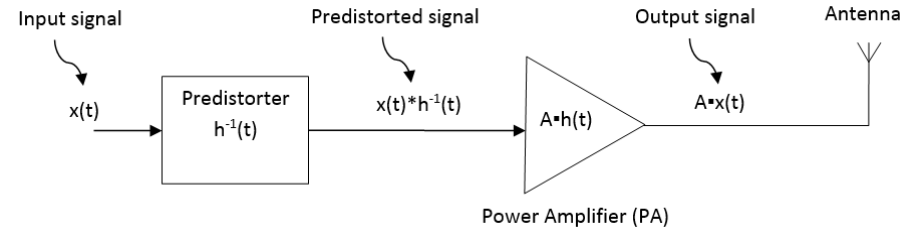
Figure 1. Basis of Predistortion Techniques.